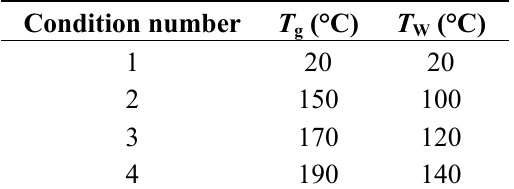
Table 2. The four different conditions of the